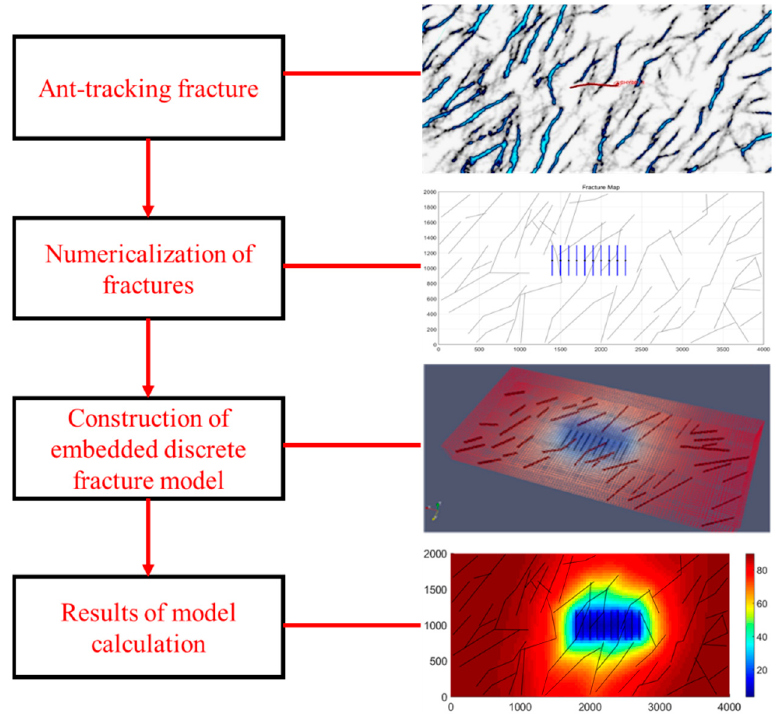
Figure 5. Numerical simulation process of embedded discrete fracture.